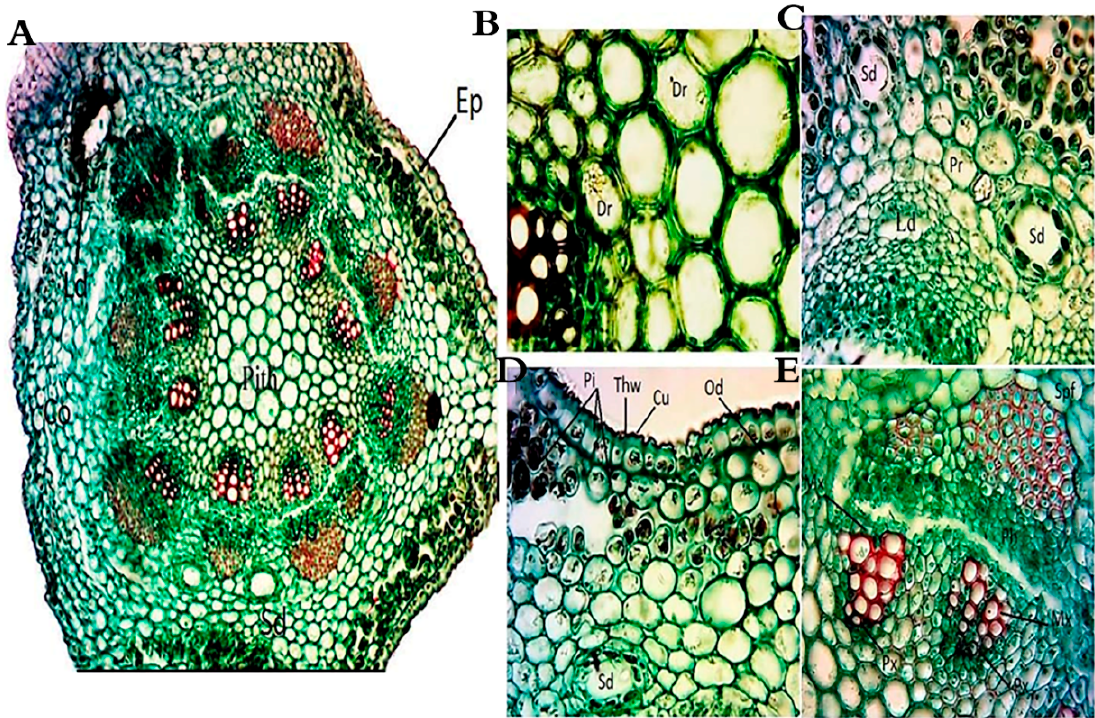
Figure 3. Anatomy of A. monosperma stem. ( A ) A transverse section in stem, Ep: epidermis, Co: cortex, Lc: lysigenous